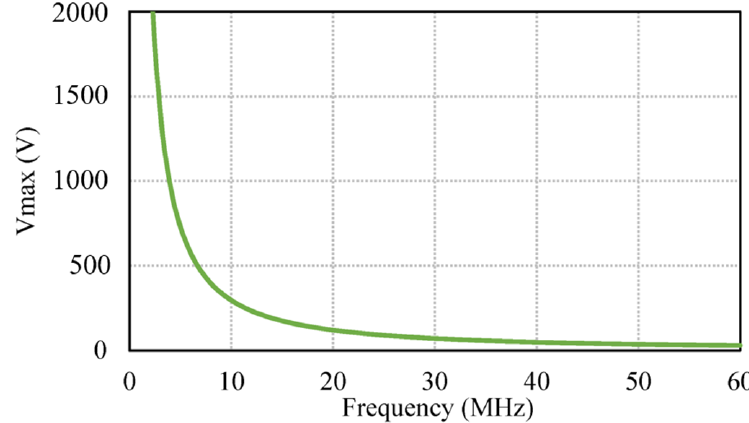
Figure 4. Maximum allowable voltage by the piezoelectric resonator as a function of the frequency for Y − 36° cut LNO.